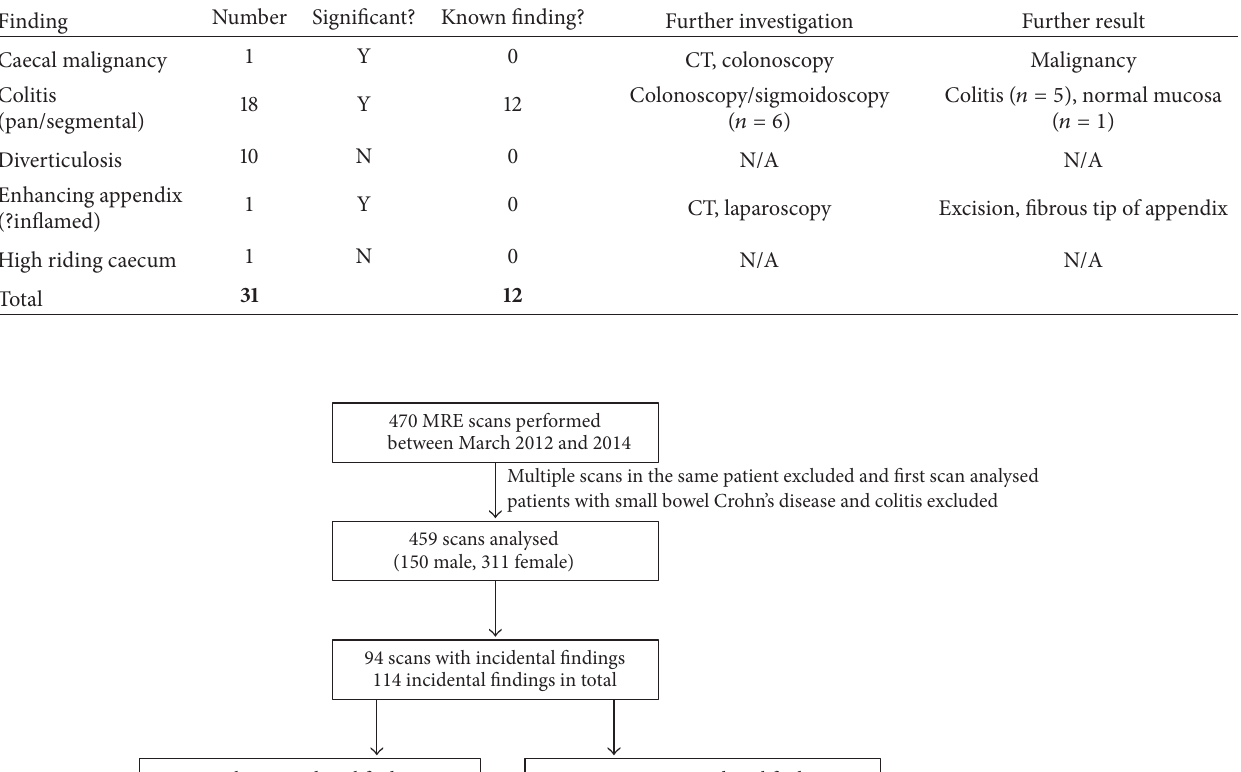
Table 1: Colonic incidental findings.